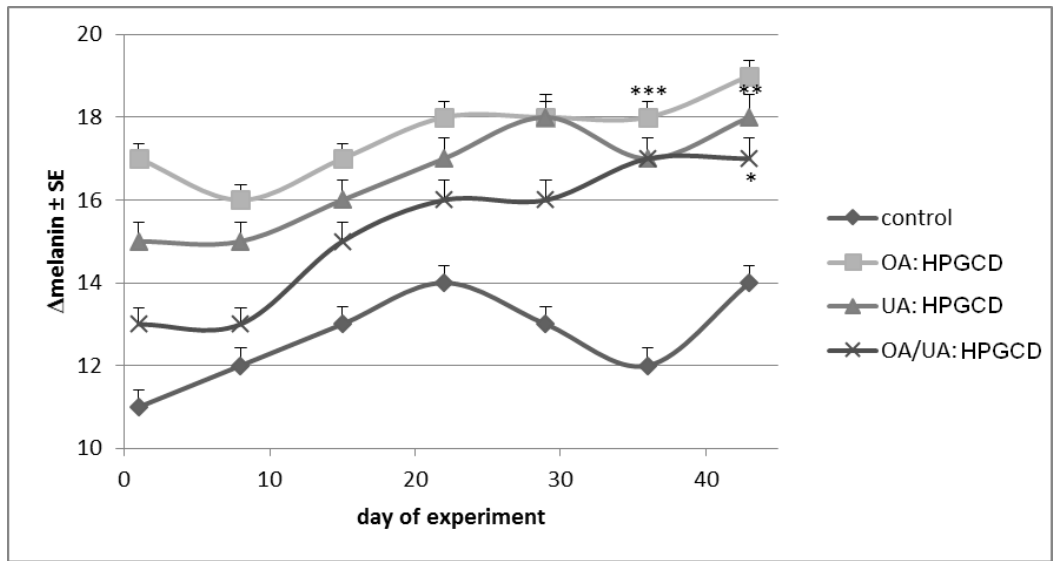
Figure 10. Melanin